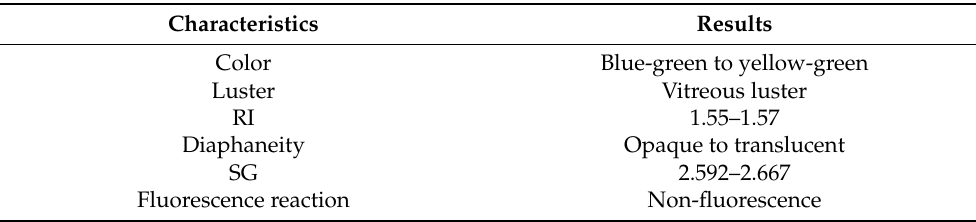
Table 1. The gemological characteristics of the serpentine jade